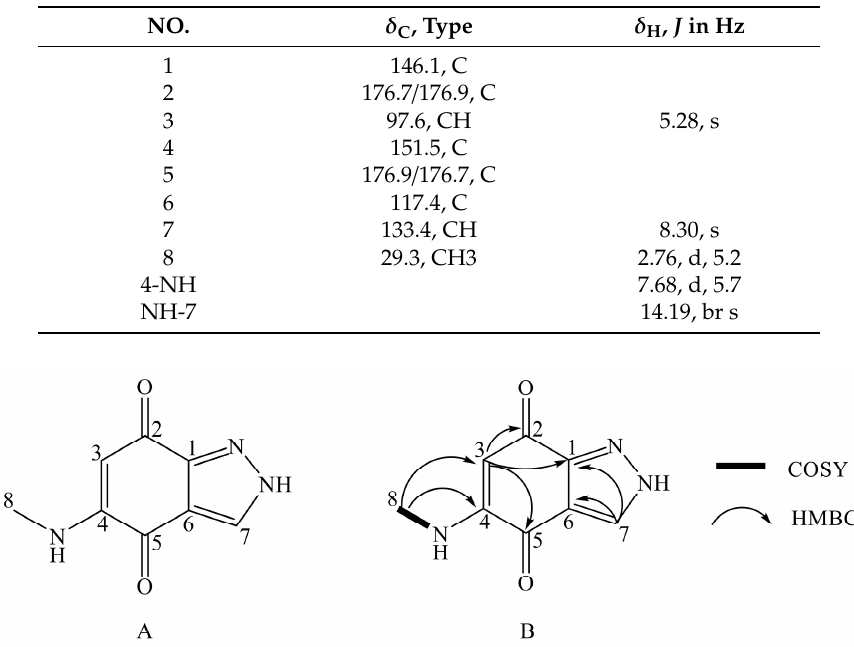
Figure 2. ( A ). Chemical structure of 1 . ( B ). Key 2D NMR correlations of 1 . Table 1. 1 H (500 MHz) and 13 C (125 MHz) NMR data of ( 1 ) in dimethyl sulfoxide (DMSO)- d 6.